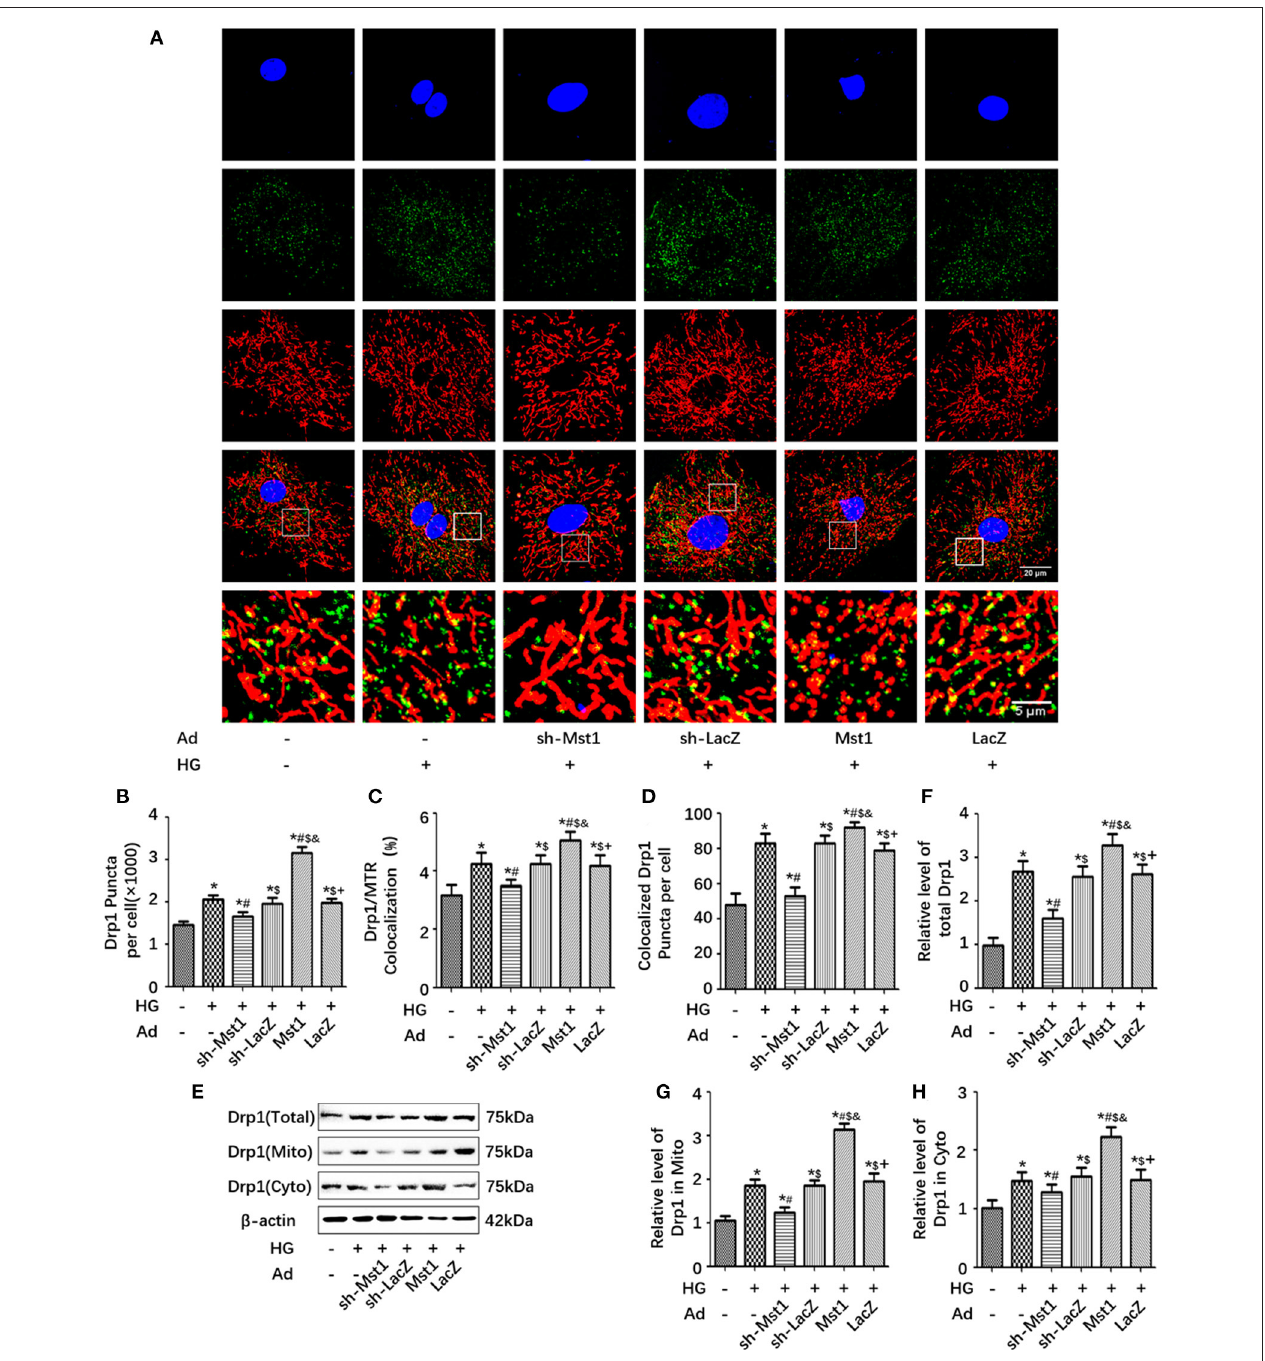
FIGURE 5 | Mst1 knockdown inhibits Drp1 recruitment to the mitochondria. (A) Representative colocalization images of Drp1 (Green) and mitochondria (MitoTracker Red) (Scale bars: upper four panels 20 µ m, lower panel 5 µ m). (B) Quantitative analysis of Drp1 puncta per cell. (C) Quantitative analysis of Drp1/ MitoTracker Red colocalization. (D) Quantitative analysis of colocalized Drp1 Puncta per cell. (E) Protein expression with representative gel blots of total Drp1, mitochondrial Drp1 and cytoplasmic Drp1. (F) Relative level of total Drp1 (G) Relative level of Drp1 in mitochondria. (H) Relative level of Drp1 in cytoplasm. The columns and error bars represent the means and SEM. * P < 0.05 vs. Con; # P < 0.05 vs. HG; $ P < 0.05 vs. HG + Ad-sh-Mst1; and P < 0.05 vs. HG + Ad-sh-LacZ; and + P < 0.05 vs. HG + Ad-Mst1.